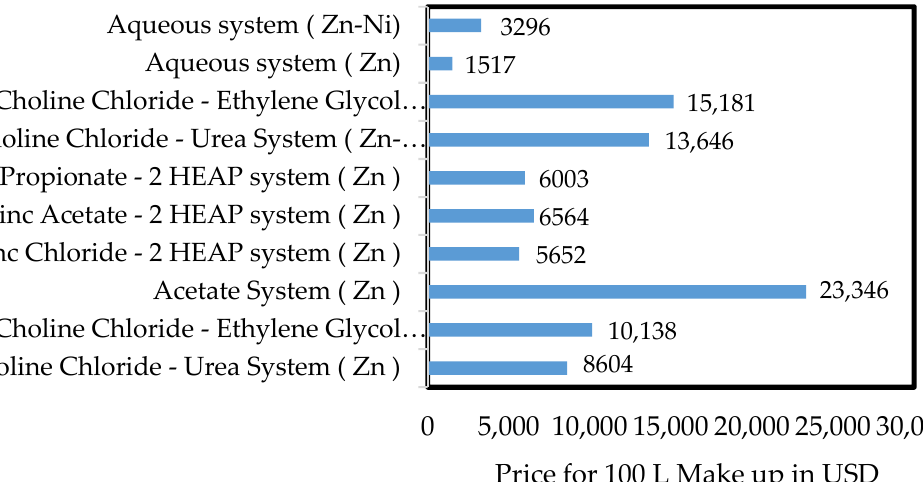
Figure 2. Plot showing the cost comparison of the ionic liquid based systems against the aqueous systems considering the initial make up of 100 L solution. HEAP: 2- hydroxyethyl ammonium propionate.